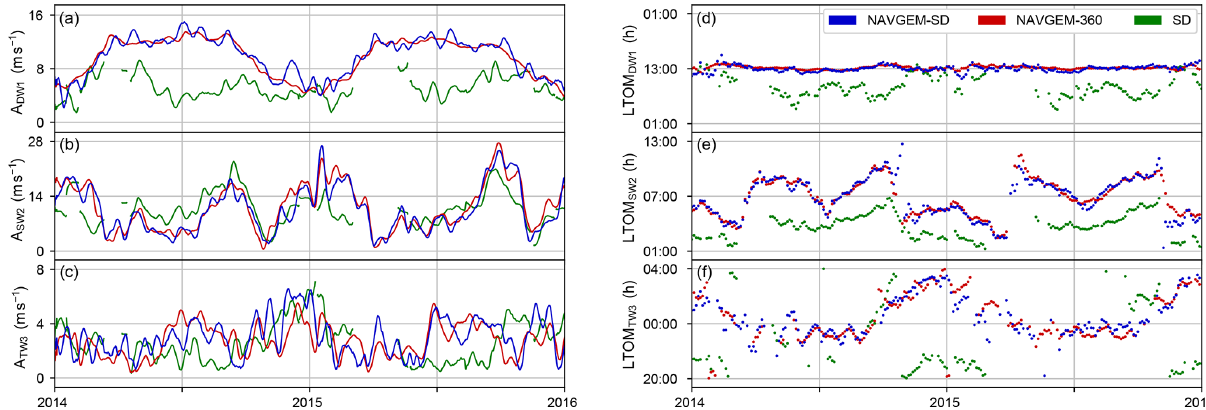
Figure 5. Amplitude and phase of DW1 (a, d) , SW2 (b, e) , and TW3 (c, f) in NAVGEM-SD (blue) and NAVGEM-360 (red) meridional winds at 82.5km altitude for the years 2014 and 2015. Phases are plotted as LTOM. Green curves show the corresponding meridional tides from around 95km altitude as measured by the array of SuperDARN (SD) radars.